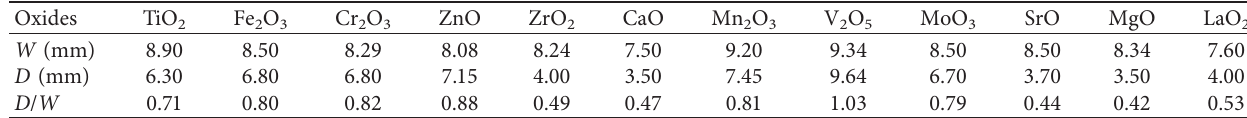
Figure 4: Hardness test locations in the FZ and HAZ of ATIG (a) and TIG (b). Table 3: Morphology of single oxide ATIG welds.